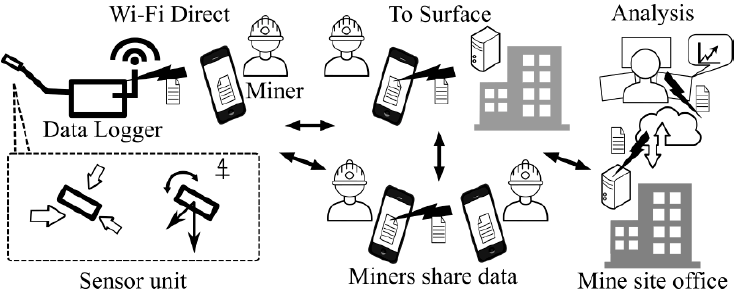
Figure 8. Design of the data transmission Wi-Fi monitoring system (Reprinted from Ref. [51]).